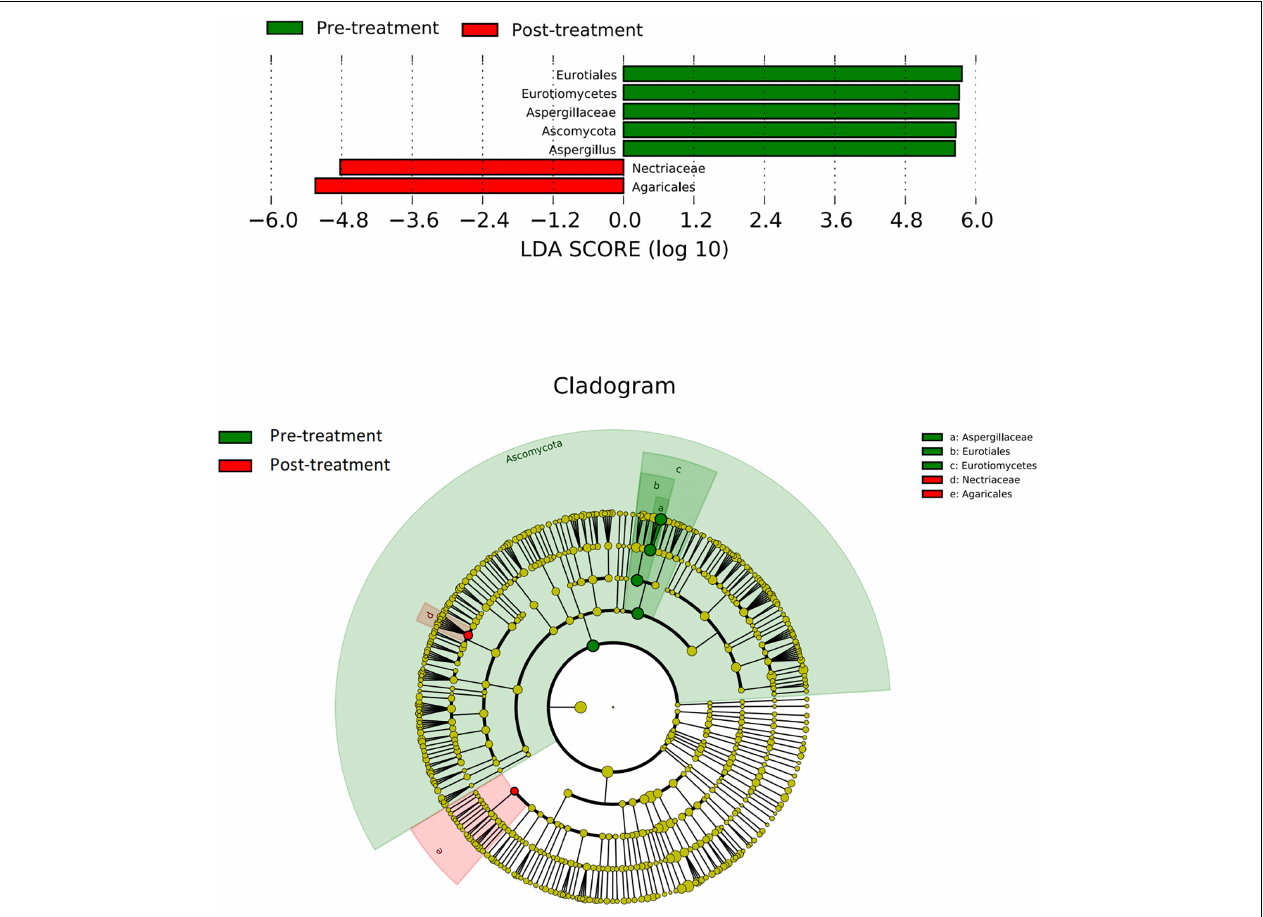
FIGURE 4 | LEfSe analysis of fungal species. The bar graph shows the LDA scores calculated for characteristics at the OTU level. Green bars refer to the pre-treatment group and red ones refer to the post-treatment group. The cladogram shows the relative abundance of OTUs. Green (light and dark green, dark green caused by overlapping of light green) and pink areas represent the pre- and post-treatment groups, respectively. Green and red nodes in the branches represent fungal species that play an important role in the two groups, respectively. Yellow nodes represent fungal species that do not play an important role in both groups. The alphabetic species names are shown in the legend on the right. Eurotiales, Eurotiomycetes, Aspergillaceae, Ascomycota, and Aspergillus were essential fungi in the pre-treatment group while Nectriaceae and Agaricales were enriched in the post-treatment